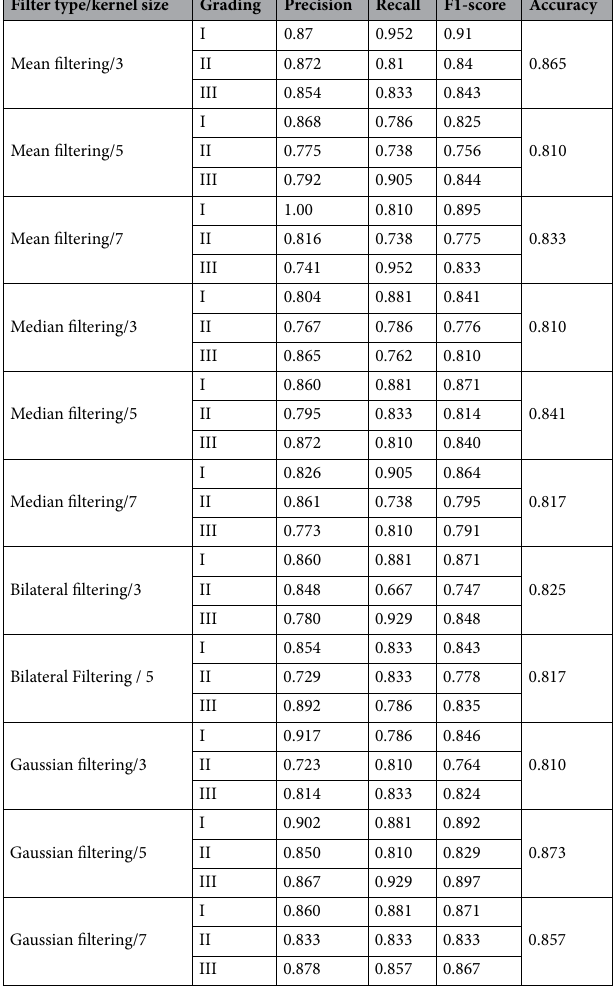
Table 4. Comparison of the denoising effect of different filtering techniques.